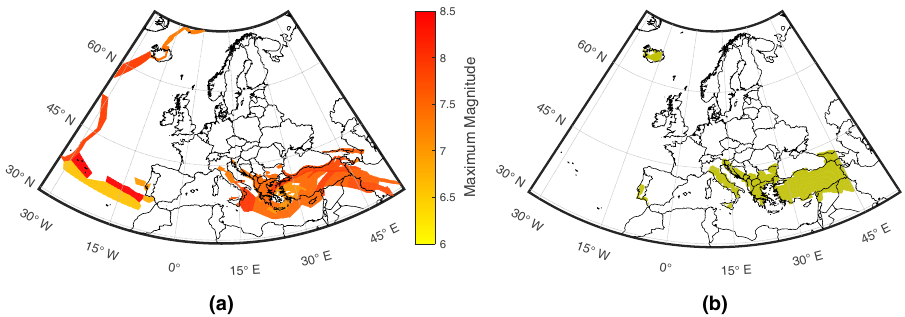
Fig. 2 Input data for lead-time mapping calculations. a Seismic sources (colour coded in accordance with corresponding modal maximum magnitude values from the seismic hazard model) and b target sites examined for lead-time calculations.